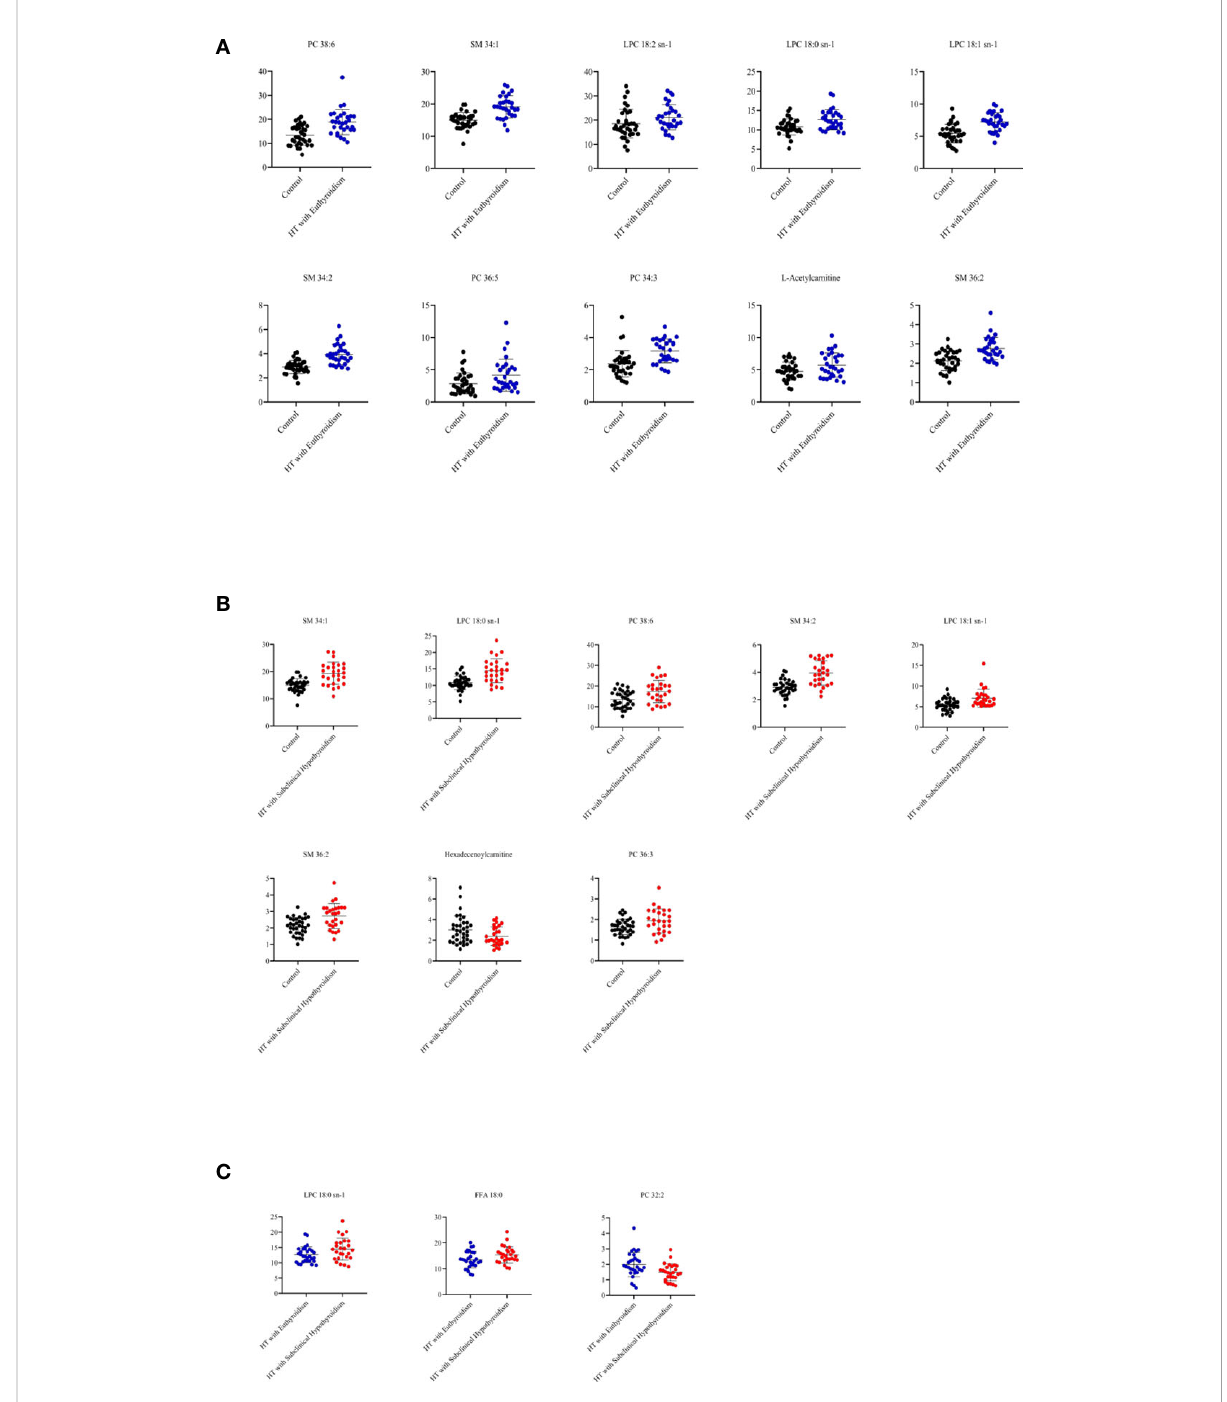
FIGURE 2 (A) The metabolites from comparison between the control and HT with euthyroidism group. (B) The metabolites from comparison between the control and HT with subclinical hypothyroidism group. (C) The metabolites from comparison between the HT with euthyroidism and HT with subclinical hypothyroidism